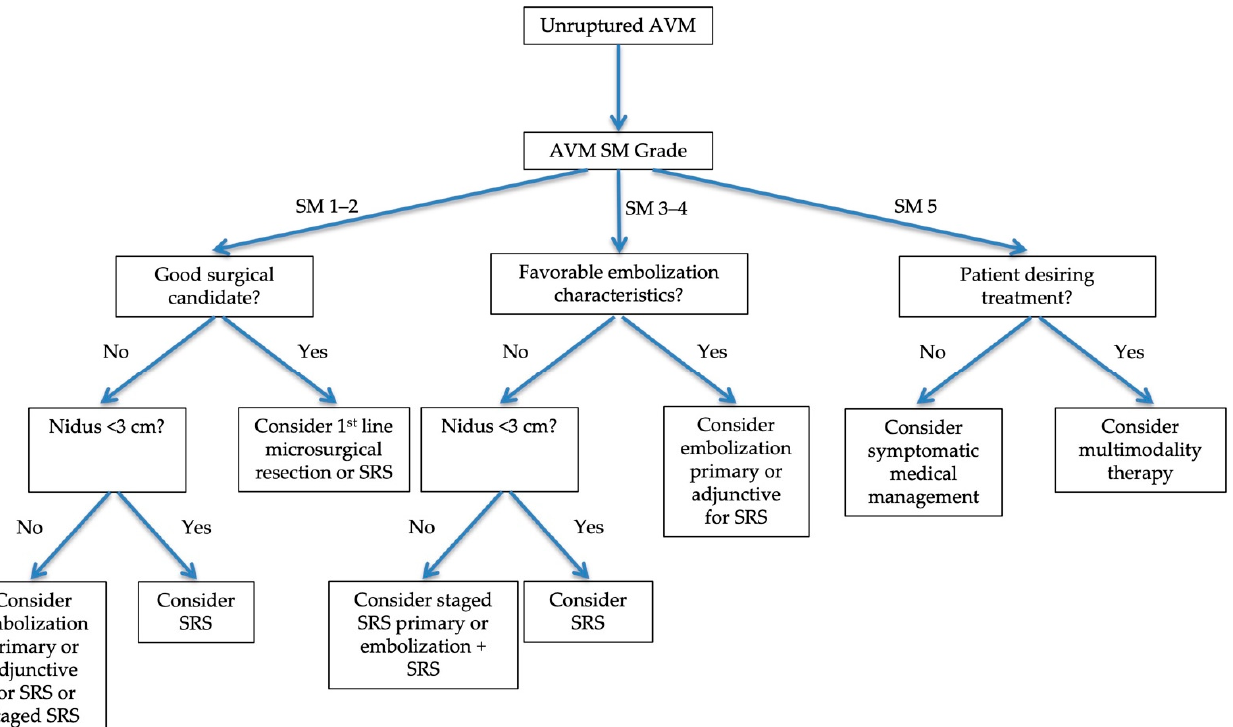
Figure 4. Flowchart outlining treatment modality decision-making algorithm for unruptured AVMs. Decision making is complex and involves consideration of AVM characteristics and shared decision making with the patient.